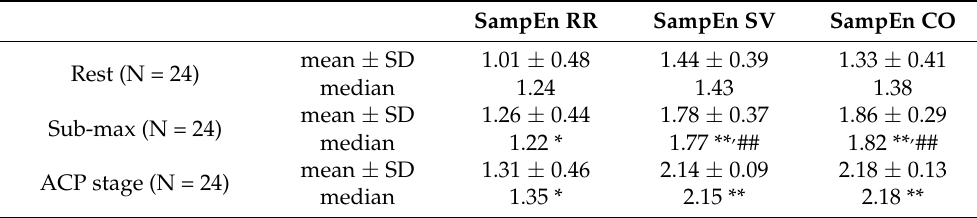
Table 2. SampEn RR, SV, and CO during the rest, sub-max, and ACP stages.